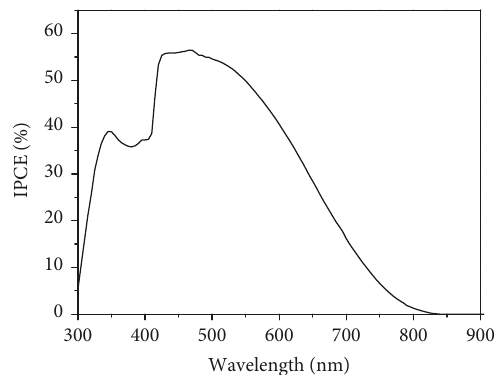
Figure 7: IPCE of the DSSC sensitized with MK-2 in acetonitrile/ tert -butyl alcohol (1 :1 by